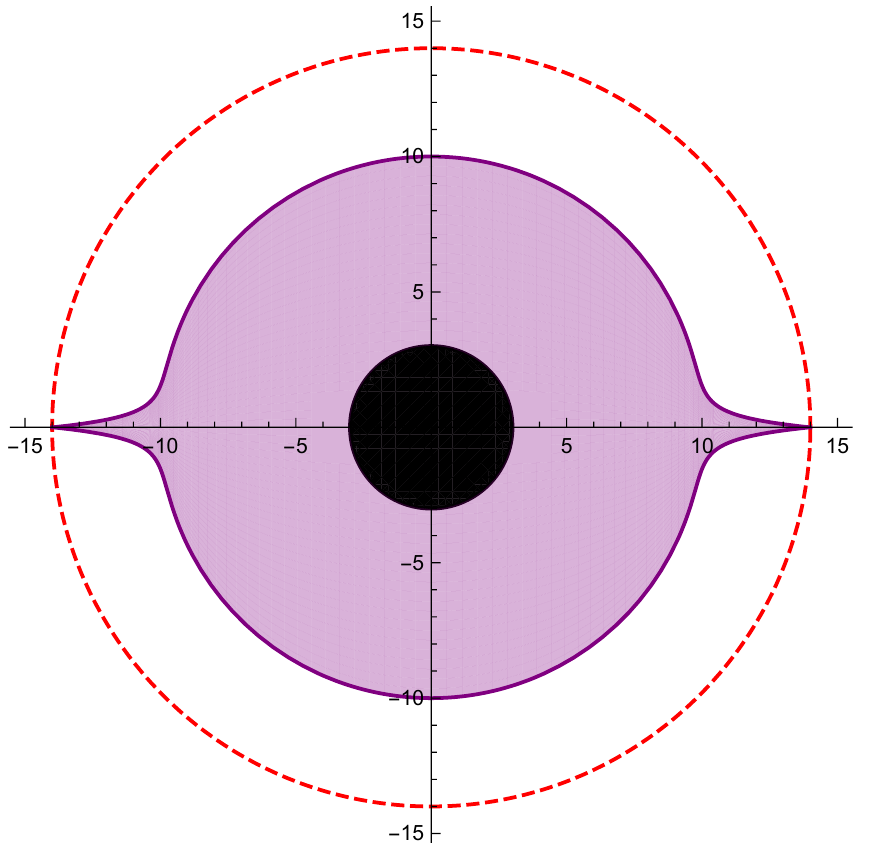
Figure 17 . A schematic (not depicted using real parameter values or curves) of the geodesic behind the brane for both individual radiation legs if the brane fractions were to saturate at 50%. The dashed red circle is the brane and the black disk is the real black hole. The darker purple curves are the pieces of spacelike geodesics which dip behind the brane and attach at the brane to the infalling geodesic coming from the radiation (inception) side of the geometry. The upper purple curve attaches to an infalling geodesic to become homologous to radiation leg R 1 , and the lower purple curve plays a similar role for leg R 2 . The lighter purple region in between the two purple curves cannot be reconstructed with access to only one radiation leg; even if two observers collecting radiation separately are communicating classically, they cannot reconstruct this